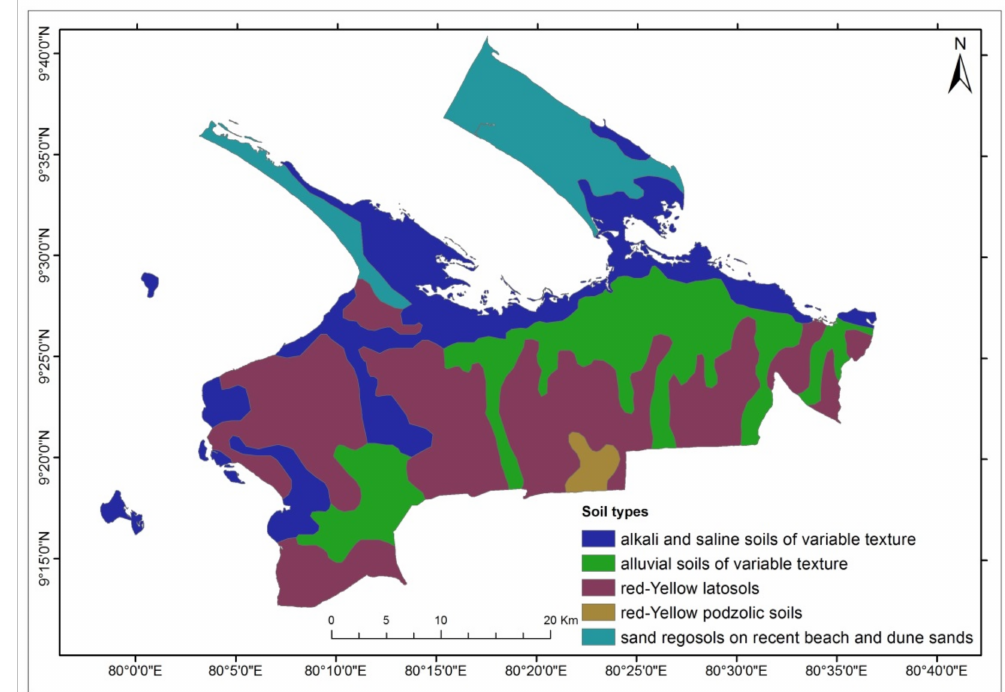
Figure 7. Soil map of Kilinochchi